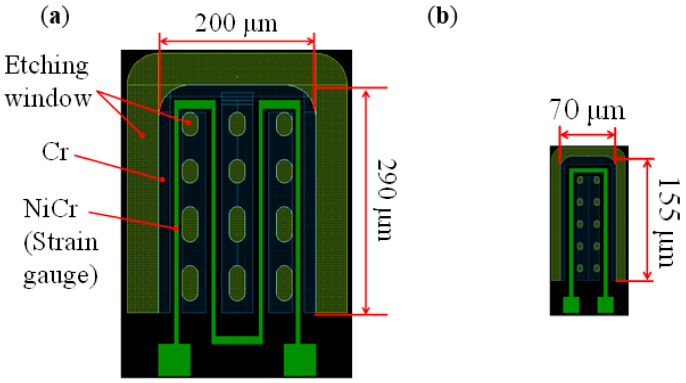
Figure 2. Design drawings of microcantilever in ( a ) previous works, and ( b ) this work.